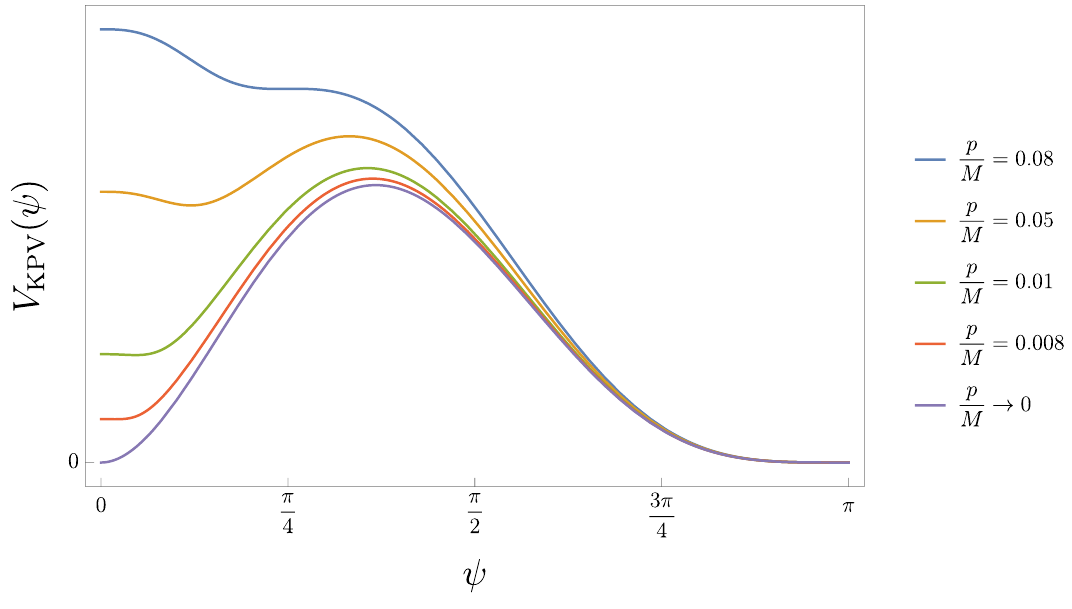
Figure 1. The potential V KPV ( ψ ) (suitably normalized) for different values of p/M